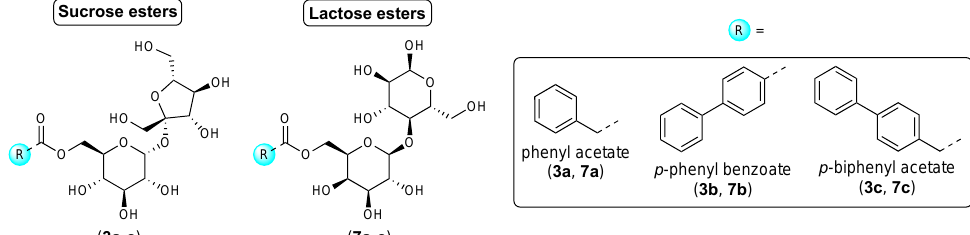
Figure 6. Chemical structures of sugar-based aromatic ester surfactants.